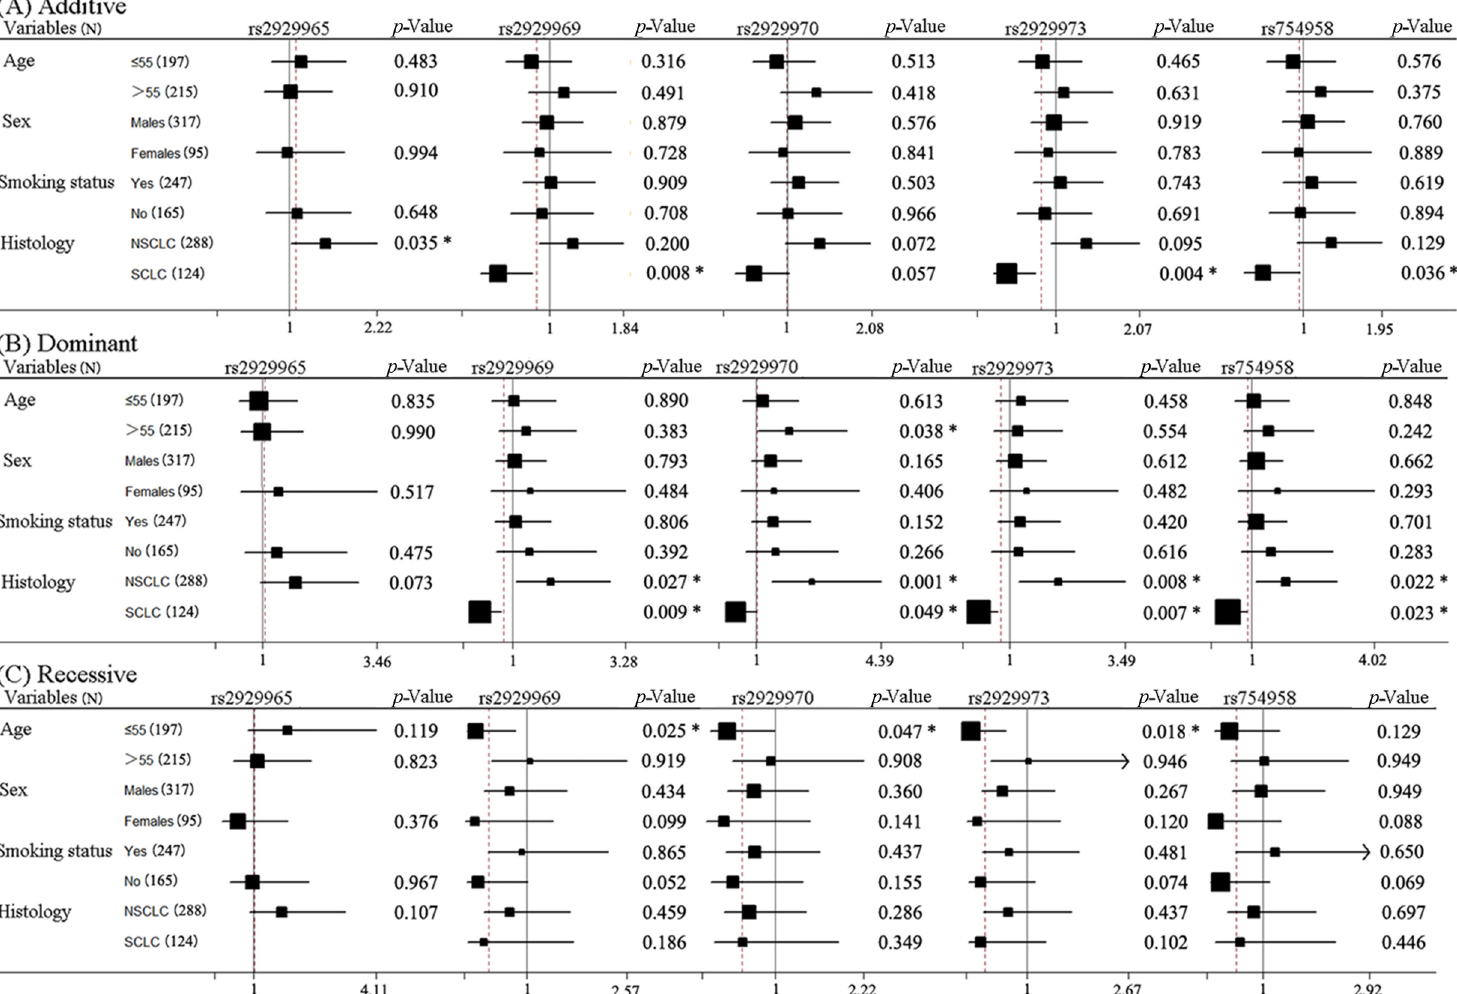
Figure 1. Stratification analyses of the associations of WISP1 rs2929965, rs2929969, rs2929970, rs2929973 and rs754958 polymorphisms with the overall chemotherapy toxicity of lung cancer. Each box and horizontal line represents the values of OR and 95% CI. NSCLC, non-small cell lung carcinoma; SCLC, small cell lung carcinoma. * p <